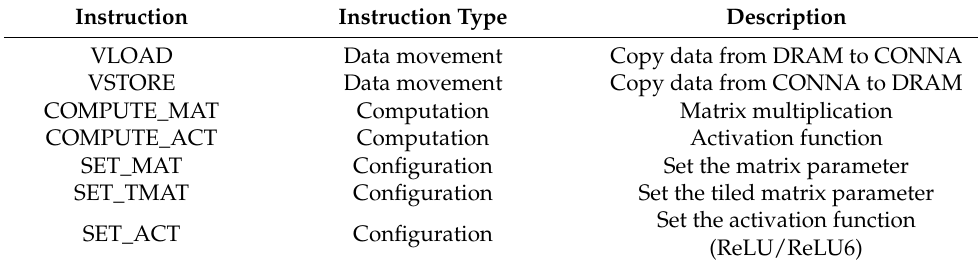
Table 7. Extended instructions for CONNA.